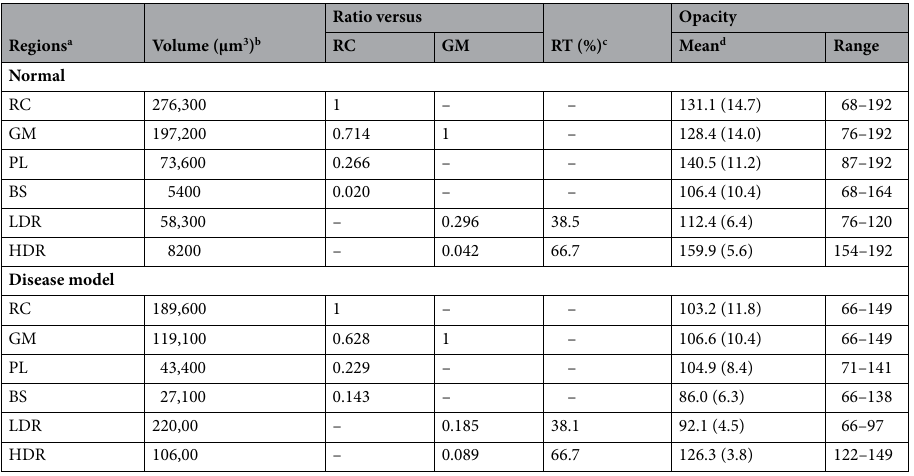
Table 2. Volumetric analysis of glomerulus. This table corresponds to Fig. 5. a Abbreviations used are: renal corpuscle (RC), glomerulus (GM), parietal layer (PL), Bowman’s space (BS), low-density regions in the glomerulus (LDR), high-density regions in the glomerulus (HDR). b Multiplied value of the voxel volume (0.154 μm 3 ) by the number of voxels. c Relative threshold calculated based on Eq. 3. d Population standard deviation is given in